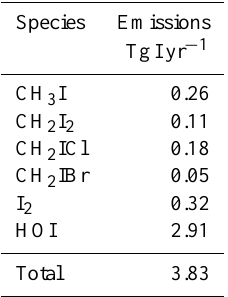
Table 1. Total simulated emissions for iodinated